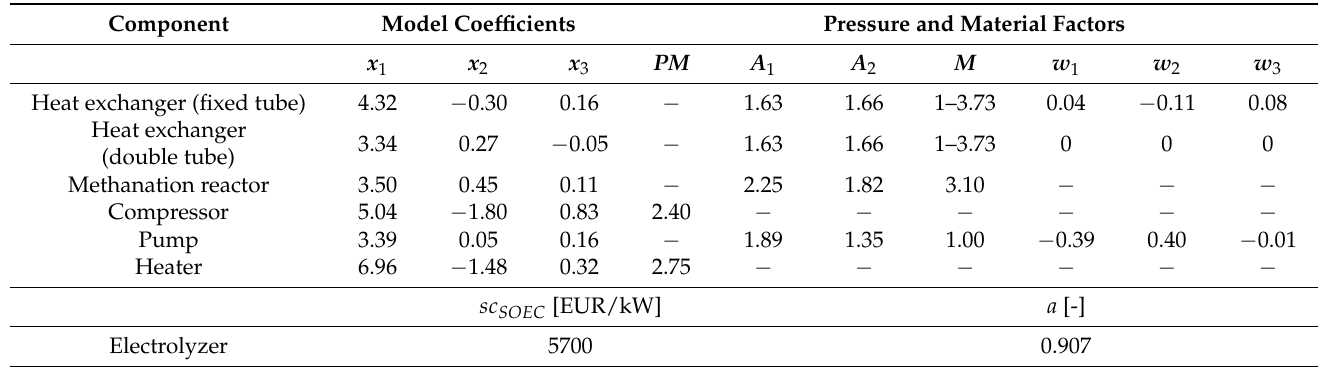
Table 3. Economic data for the components of the system (table elaborated using data by [28–35]).